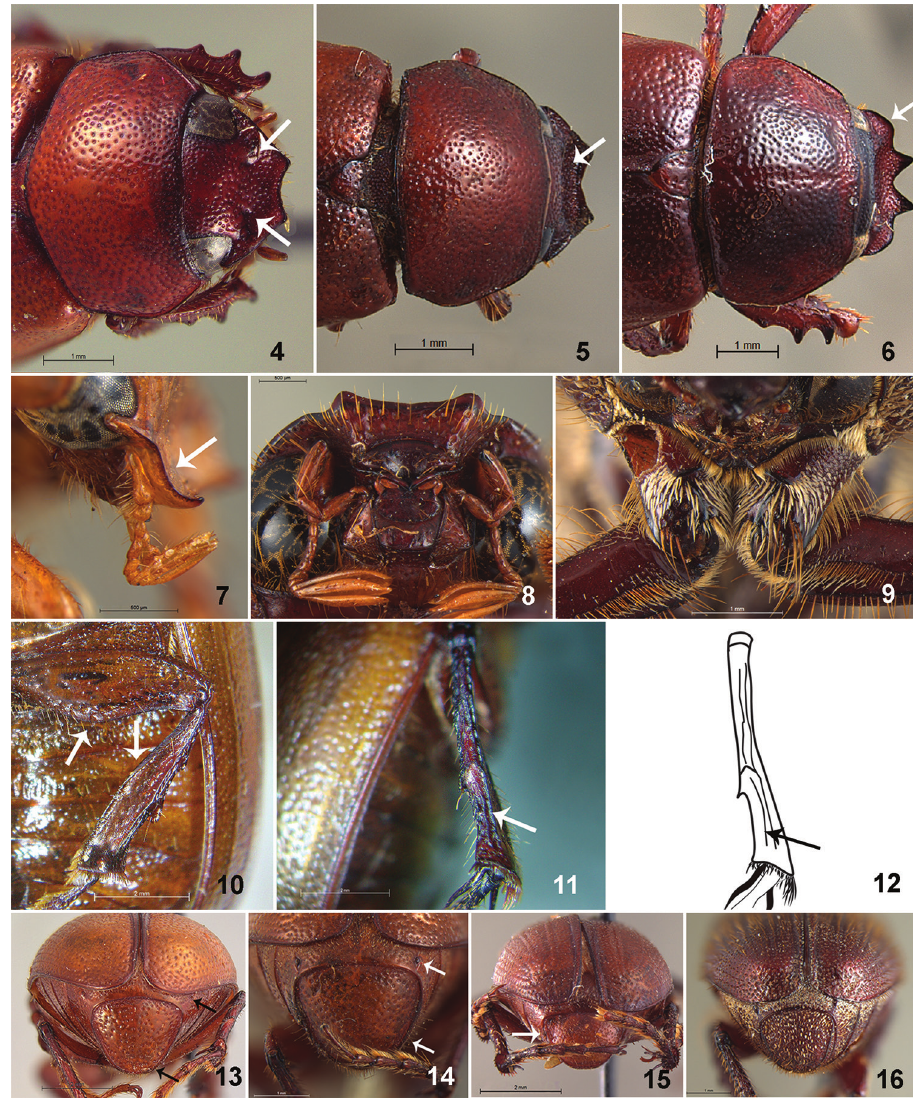
Figures 4–16. 4 Liogenys bidenticeps Moser fronto-clypeal impressions 5 L. santaecrucis Blanchard frons and clypeus concave 6 L. forcipata Frey clypeal lateral projection 7 L. flavida Moser clypeus S-shaped 8 L. testaceipennis Moser clypeus and labrum, ventral view 9 L. fusca Blanchard procoxae 10 L. tibialis Moser metafemur and tibia 11–12 L. santaecrucis Blanchard metatibia, posterior view 13–16 Pygidium: 13 L. spiniventris Moser 14 L. quadridens (Fabricius) 15 L. cartwrighti Frey 16 L. densicollis